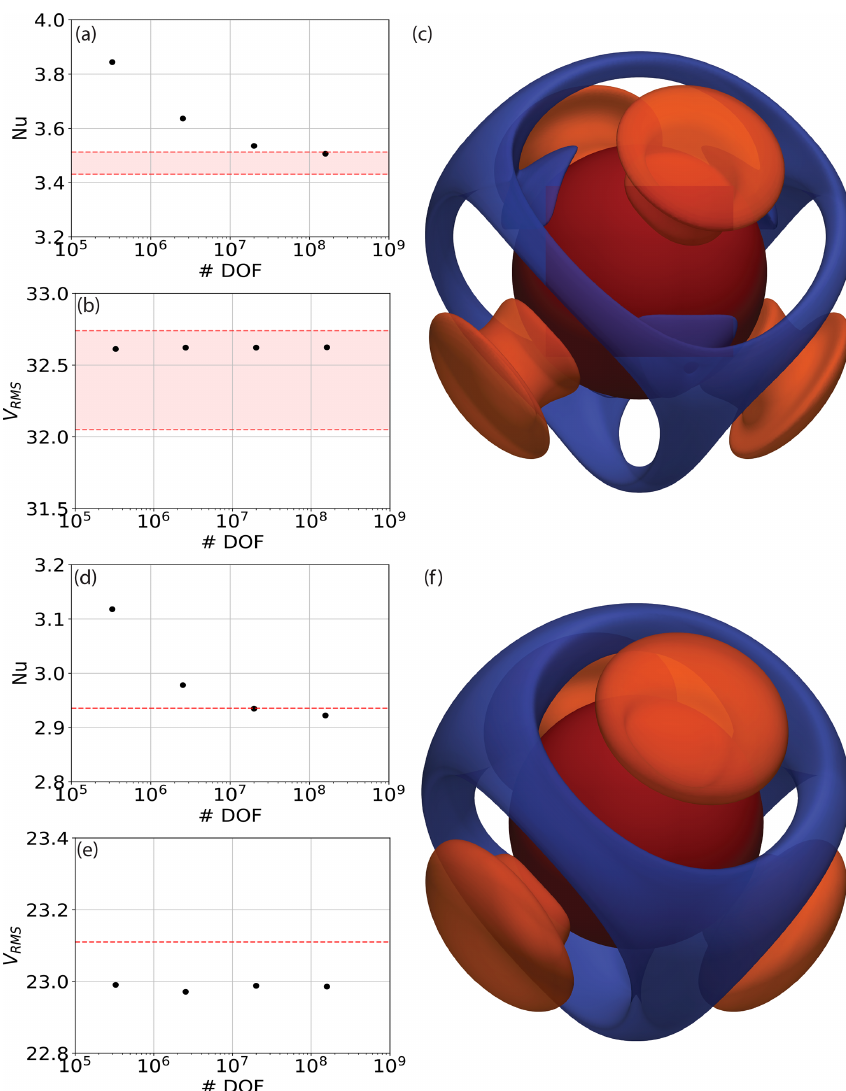
Figure 8. (a, b) Nusselt number/rms velocity vs. number of pressure and velocity DOFs, designed to match an isoviscous 3-D spherical shell benchmark case at Ra = 7 × 10 3 for a series of uniform, structured meshes. The range of solutions predicted in previous studies is bounded by dashed red lines (Bercovici et al., 1989; Ratcliff et al., 1996; Yoshida and Kageyama, 2004; Stemmer et al., 2006; Choblet et al., 2007; Tackley, 2008; Zhong et al., 2008; Davies et al., 2013; Liu and King, 2019). (c) Final steady-state temperature field highlighted through isosurfaces at temperature anomalies (i.e. away from the radial average) of T = − 0 . 15 (blue) and T = 0 . 15 (orange), with the core–mantle boundary at the base of the spherical shell marked by a red surface; (d–f) as in (a) – (c) but for a temperature-dependent viscosity case, with thermally induced viscosity contrasts of 10 2 . Fewer codes have published predictions for this case, but results of Zhong et al. (2008) are marked by dashed red lines for